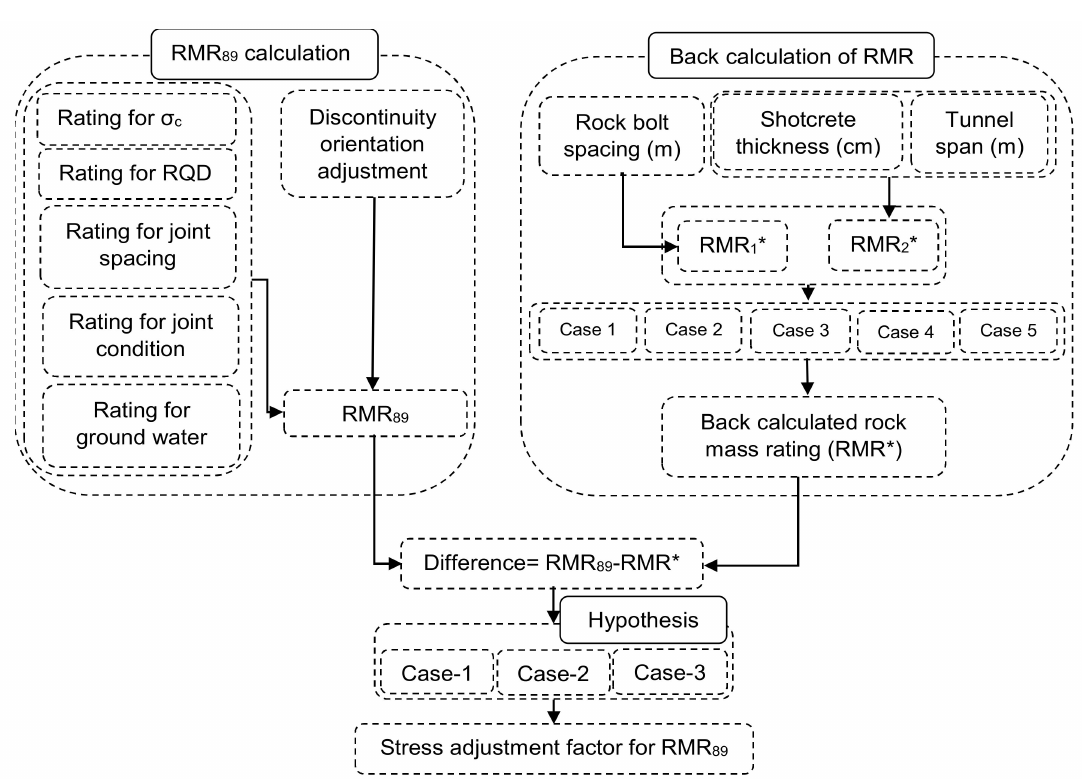
Figure 10. Procedure for determining stress adjustment factor (F stress ) in rock mass rating 89 (RMR 89 ), while considering the five cases listed in Table 6 (modified after